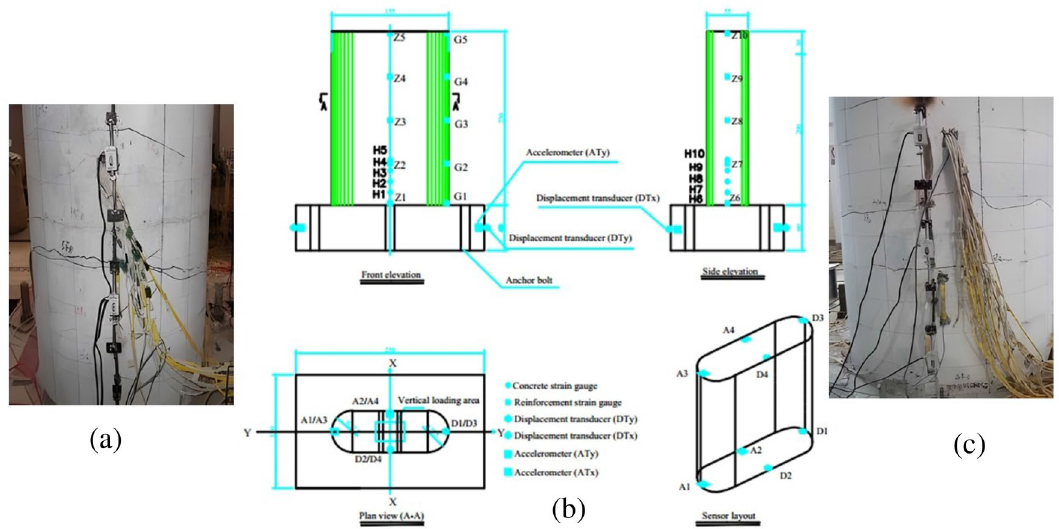
Figure 7. Instrumentation of data acquisition devices for experimental RERSCSS concrete piers used in HSRB specimen (unit: mm). ( a ) Test diagram of the x-direction sensor arrangement, ( b ) Schematic diagram of the sensor arrangement, and ( c ) test diagram of the sensor arrangement in y-direction.